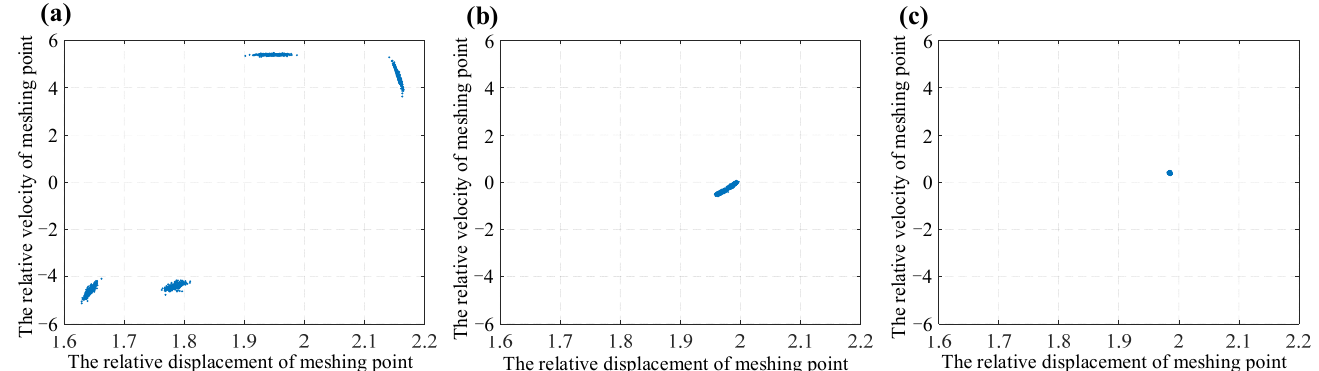
Figure 22. Poincare section diagram with different ζ . ( a ) ζ = 0.01. ( b ) ζ = 0.05. ( c ) ζ = 0.1.